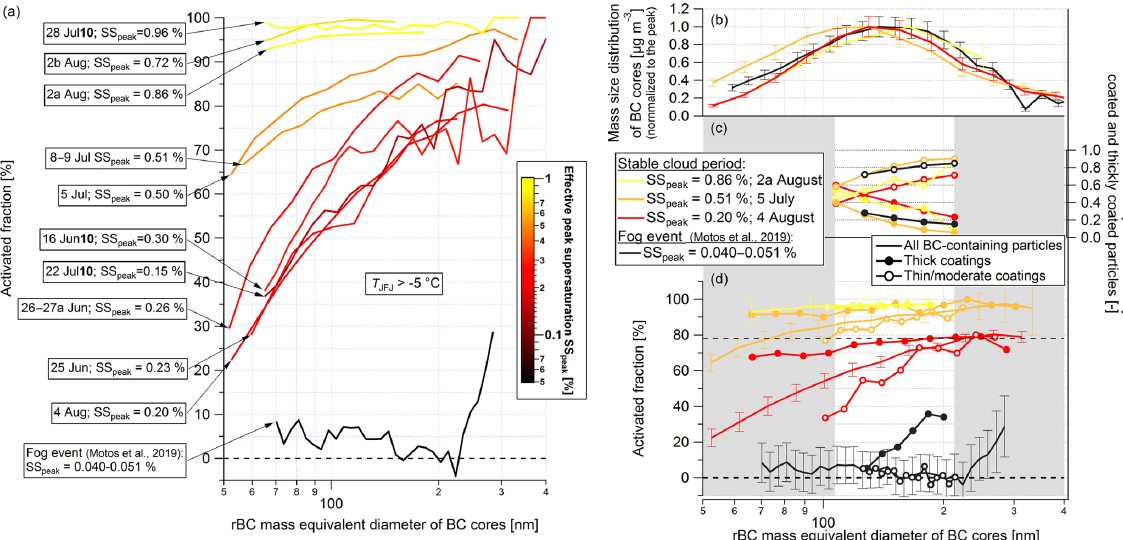
Figure 9. Activation of BC to cloud droplets. (a) Activated fraction of all BC cores as a function of rBC mass equivalent diameter for all stable cloud periods with T JFJ > − 5 ◦ C, coloured by SS peak . One fog event, extracted from the study of Motos et al. (2019), is also shown. Two variants of this figure, including clouds with T JFJ below − 5 ◦ C (Fig. S3a) and SMPS-derived activation plateau (Fig. S3b), are shown in the Supplement. (b) BC core mass size distribution behind the total inlet. (c) Number fraction of BC cores with thin to moderate or thick coatings as determined with the delay time method behind the total inlet. The most thickly coated particles, which caused saturation of the scattering signal, were included in the subset of BC-containing particles with thick coatings. The grey shadings indicate ranges of mass equivalent diameter for which the detection limits of the SP2 may introduce biases. (d) Activated fraction of all BC cores (same as in panel a ) differentiated for the subsets of cores with thin to moderate coatings or thick coatings. This is only shown for three representative example stable cloud periods and one fog